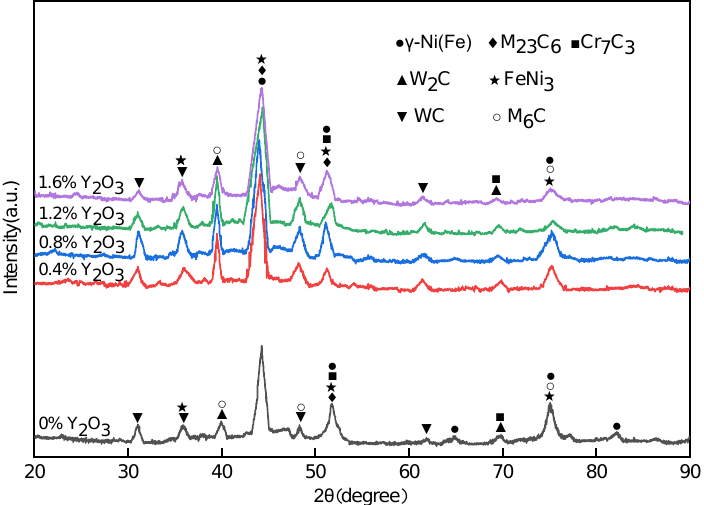
Figure 8. X-ray diffraction pattern of surfacing layer with different Y 2 O 3 content.